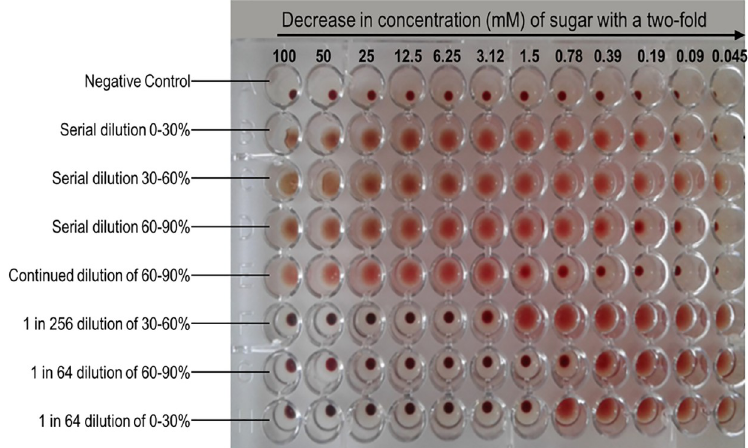
Fig 3. Haemagglutination and haemagglutination inhibition assay of the three partially purified fractions of B . edulis .